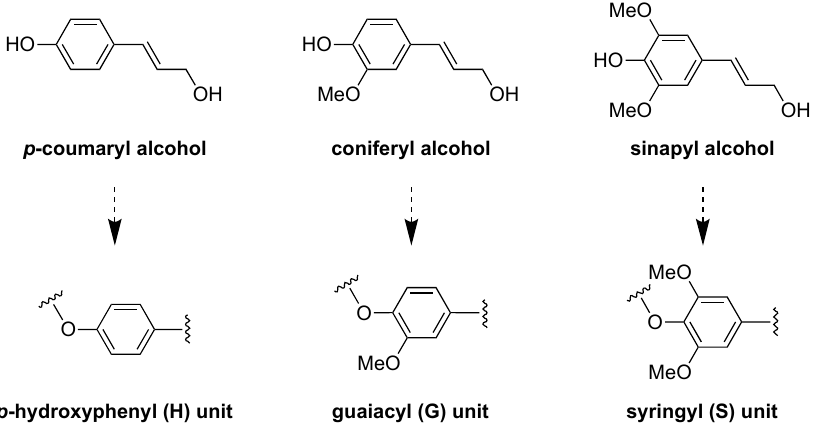
Figure 1. Main three lignin-building blocks (monolignols) (top). The corresponding units found in the lignin structure: p -hydroxyphenyl (H), guaiacyl (G), and syringyl (S) units (bo tt om).